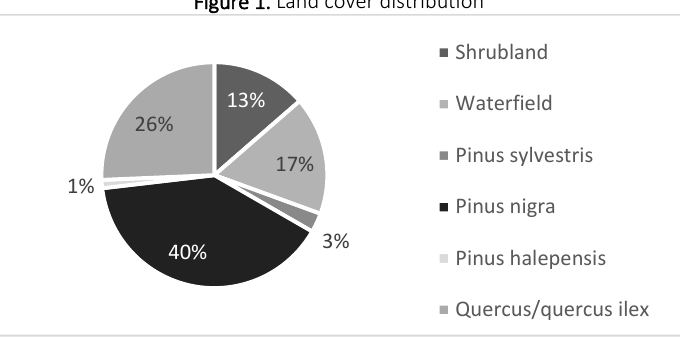
Figure 1. Land cover